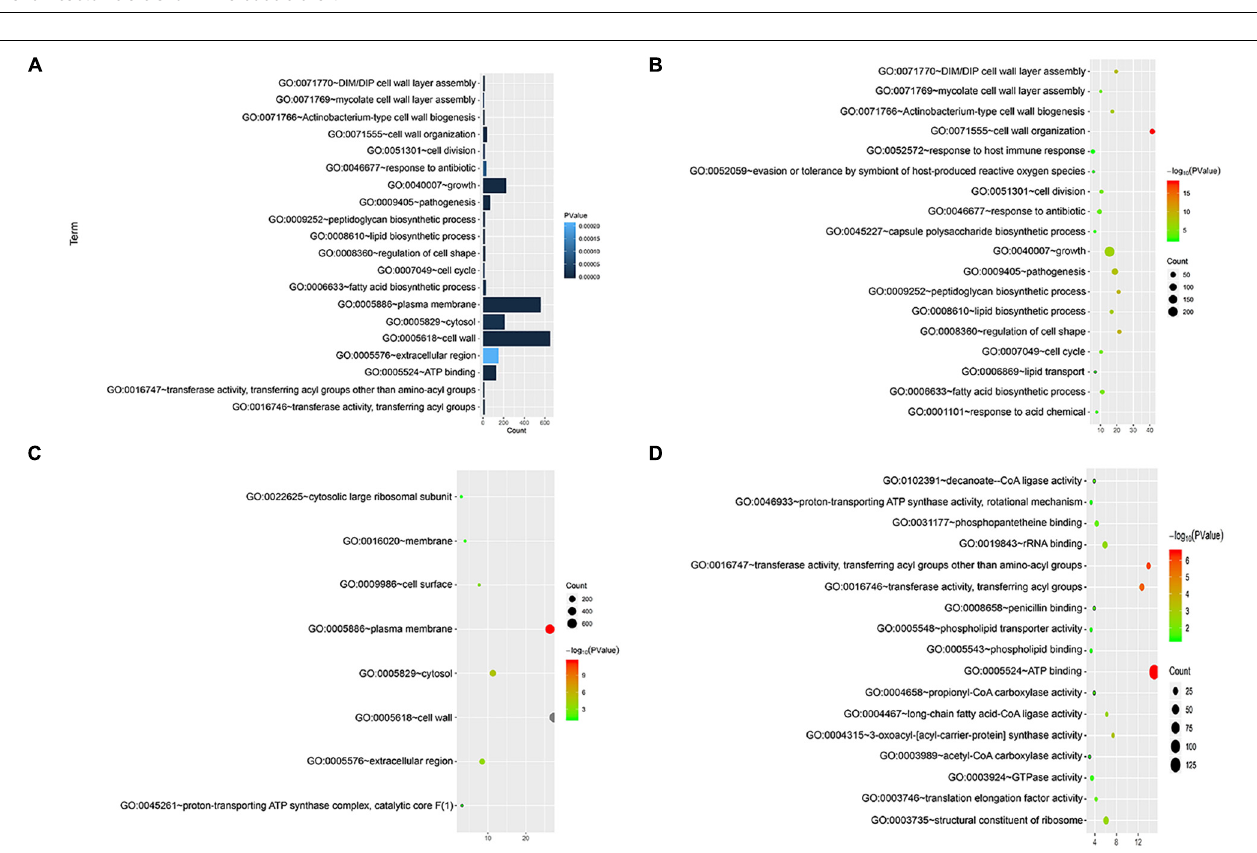
FIGURE 2 | Functional significance analysis of cell wall-related genes in the standard strain of M. tuberculosis H37Rv. (A) Histogram showing the top 20 pathways identified in function analysis of cell wall-related genes. (B–D) Bubble charts showing the top 20 pathways in BP, CC, and MF.